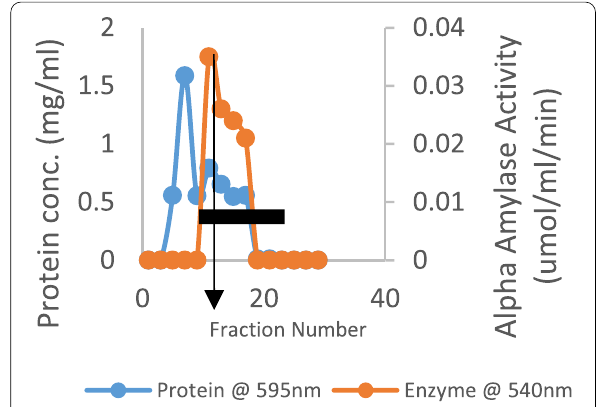
Fig. 1 Purified amylase from P. tuber-regium on ion exchange chromatography